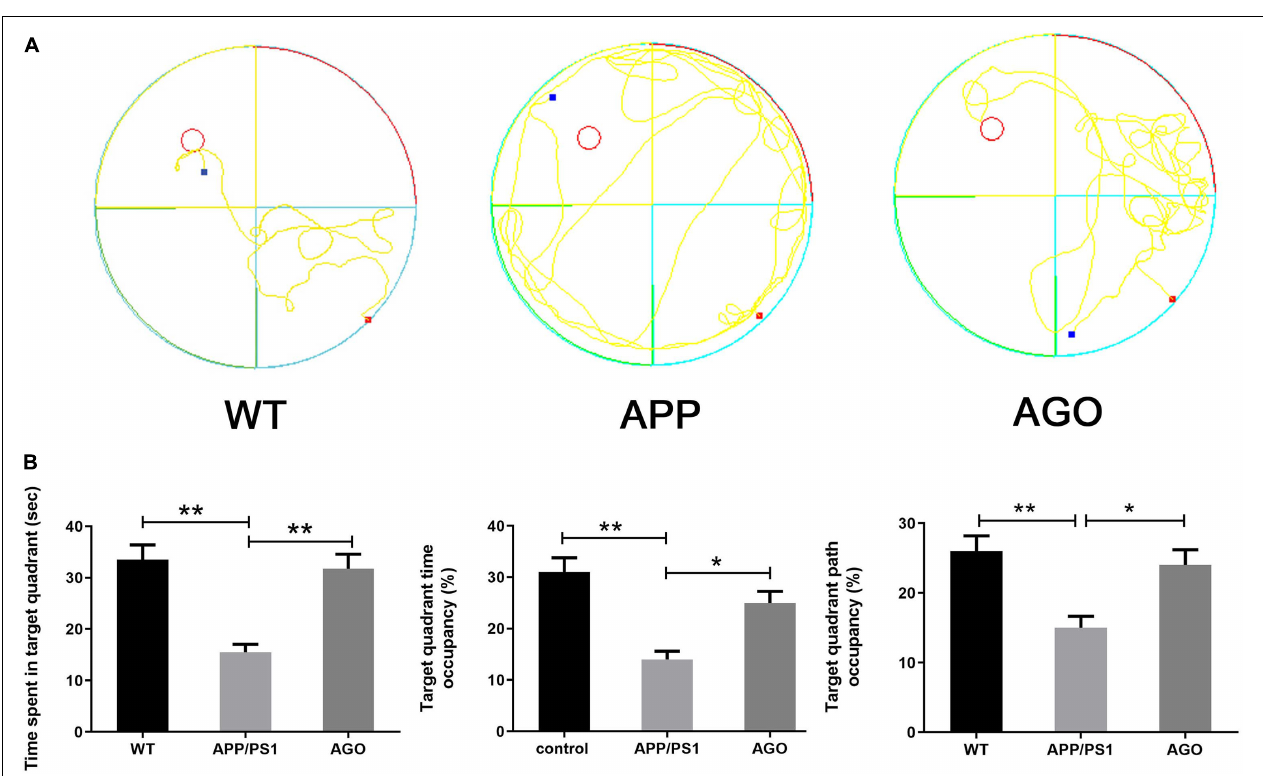
FIGURE 1 | Effects of agomelatine on the spatial learning and memory performance in APP/PS1 mice. In the agomelatine-treated group, mice were intraperitoneally injected with agomelatine (50 mg/kg/day) for 30 days. (A) Performance of Morris water maze in APP/PS1 mice. (B) Measurement of the time spent in target quadrant, target quadrant time occupancy, and path length occupancy in the target quadrant by Morris water maze. Values are represented as the mean ± SEM ( n = 10). * P < 0.05; ** P <